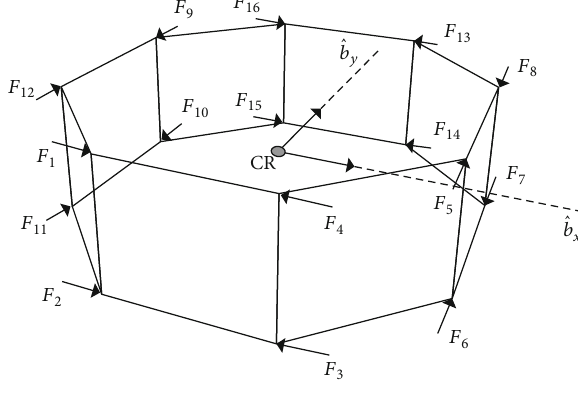
Figure 2: Distribution of the thrusters. Table 3: Model parameters.